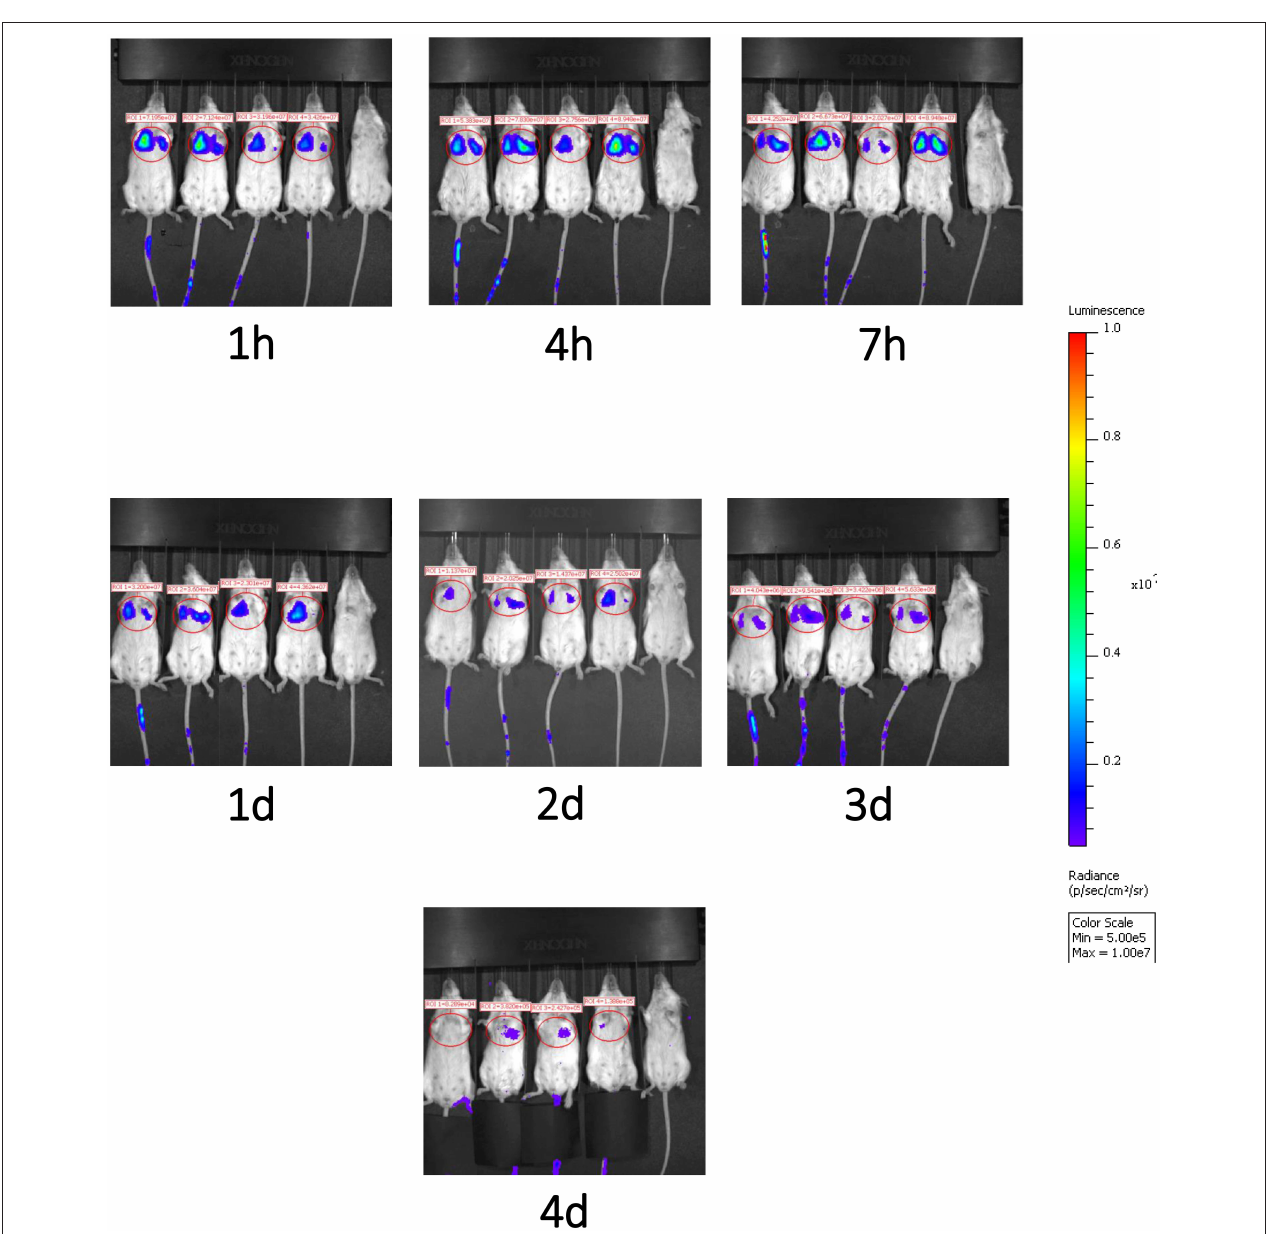
FIGURE 5 | Migration pattern of i.v. infused human DSCs in healthy mice. Migration pattern of systemic infused stromal cells, in live animals, was done by using labeled cells. Human DSCs were transduced with Luciferin gene containing GFP using lentivirus vector (methods). 1 × 10 6 cell/mouse were infused i.v. and after light anesthesia, live animals ( N = 2) were kept in IVIS CCD camera and at different time points whole body scan were recorded. Infused cells first pass to the lung and stayed there up to 4 days. In the Luciferin tracking model, just live cells will be recorded. It means that the human DCs mainly reside it the lung.